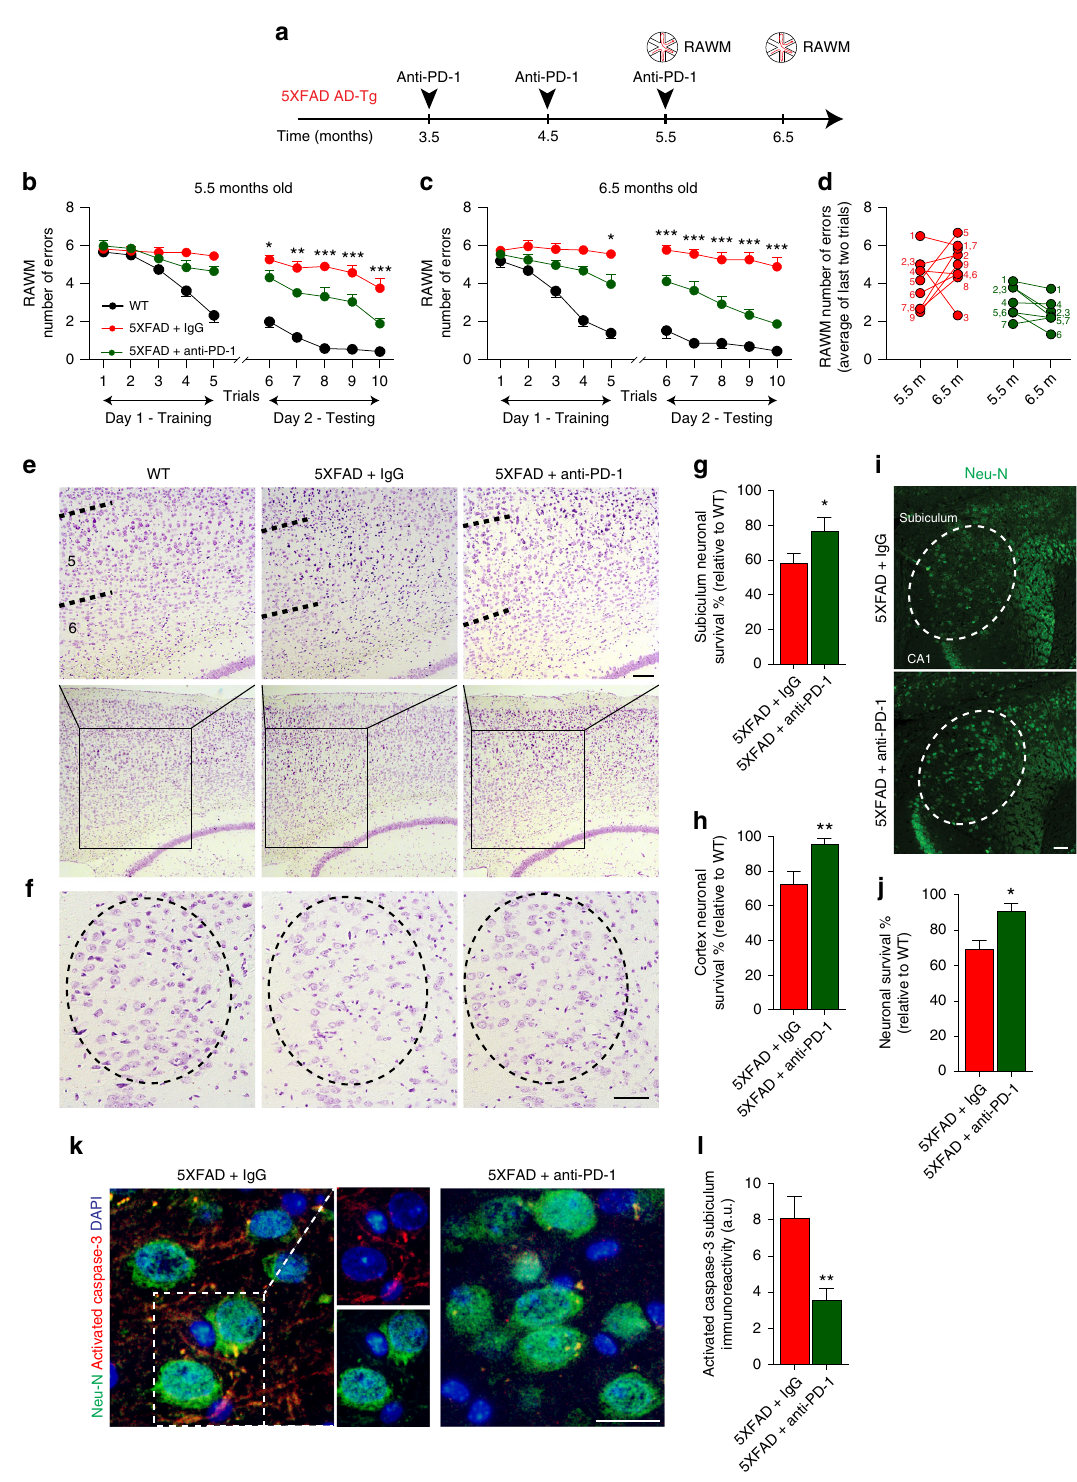
experimental design for all antibodies tested in this set of experiments is shown in Fig. 2a). In the fi rst experiment, 6- month-old 5XFAD mice were treated with a single dose of anti- PD-L1 antibody (0.1, 0.5, or 1.5 mg per mouse), injected intra- peritoneally. Mice were assessed 1 month later, using RAWM. While 0.1 mg of anti-PD-L1 did not have any effect on cognitive performance compared to treatment with IgG2b, the relevant isotype control, both 0.5 and 1.5 mg doses had a similar bene fi cial effect; the higher dose was slightly superior, though the